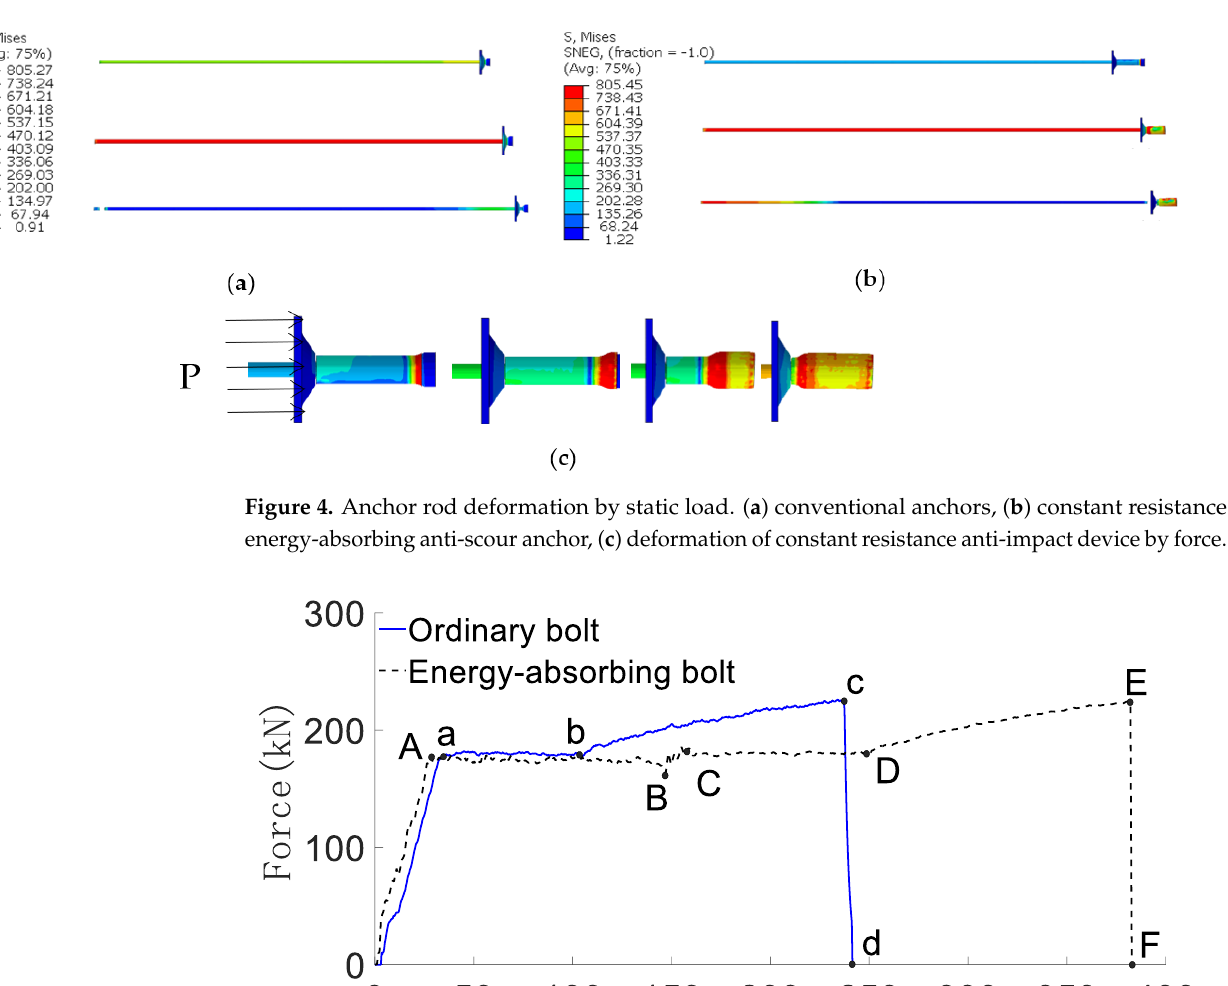
Figure 5. Anchor force-displacement curve.